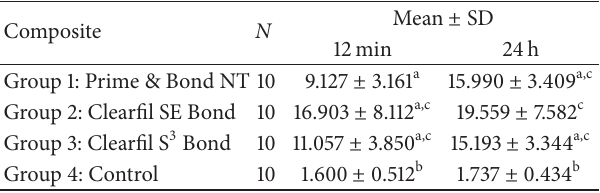
Table 2: Mean shear bond strength values of adhesives (MPa) to